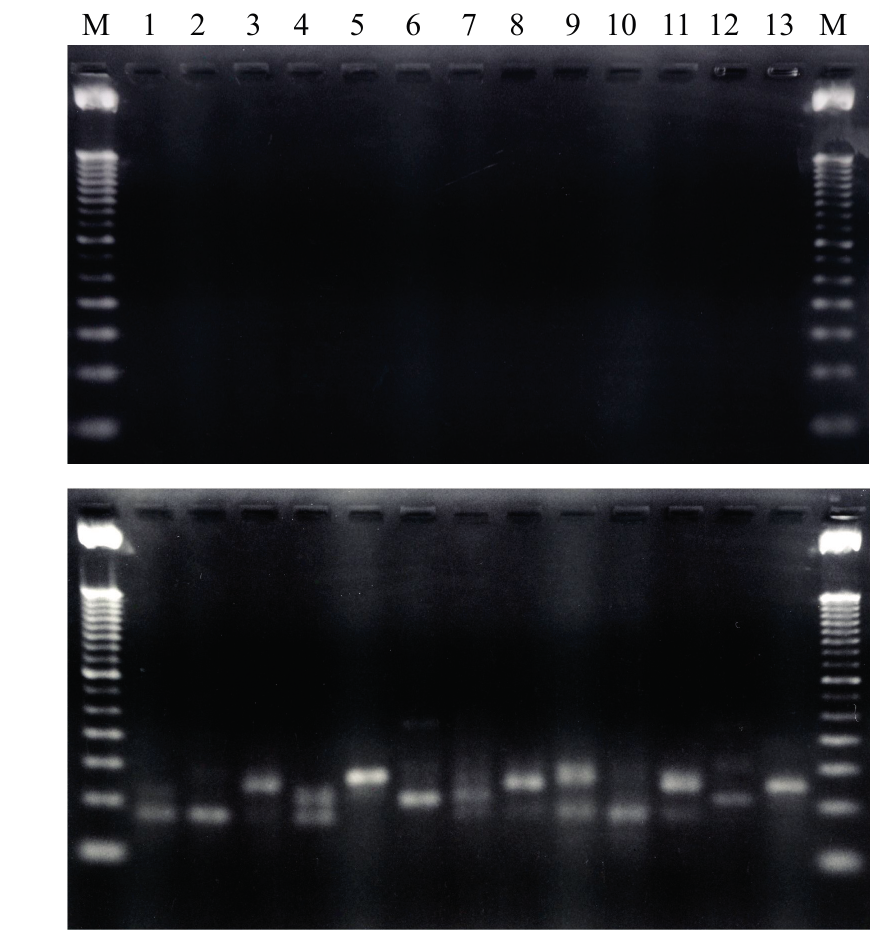
Figure 2. Agarose electrophoresis patterns of RT-PCR-amplified fragments. ( A ) Amplified without RT (reverse transcriptase); ( B ) Amplified with RT. Lanes 1 to 13 contain fragment that were amplified with primer sets 15–27 summarized in previous work; these primers were described previously [9]. M: 100 bp ladder